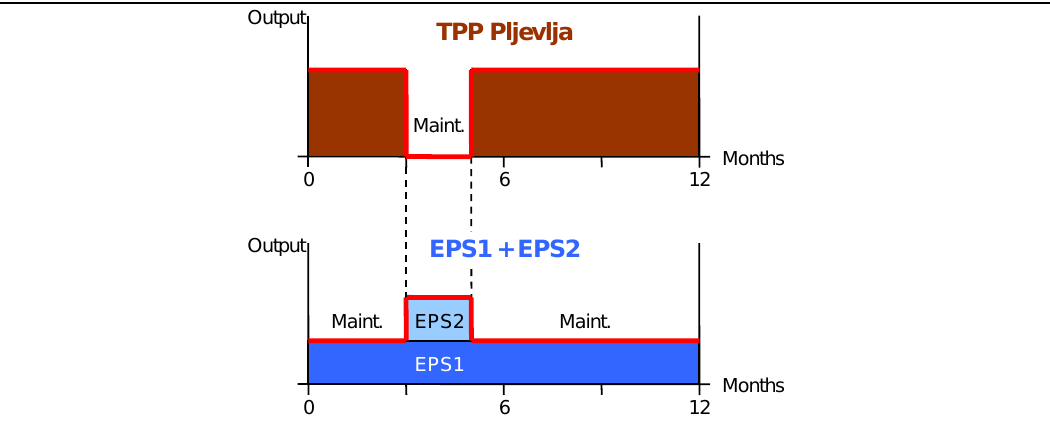
Figure 7. Specifying maintenance schedules in order to represent base power imports.